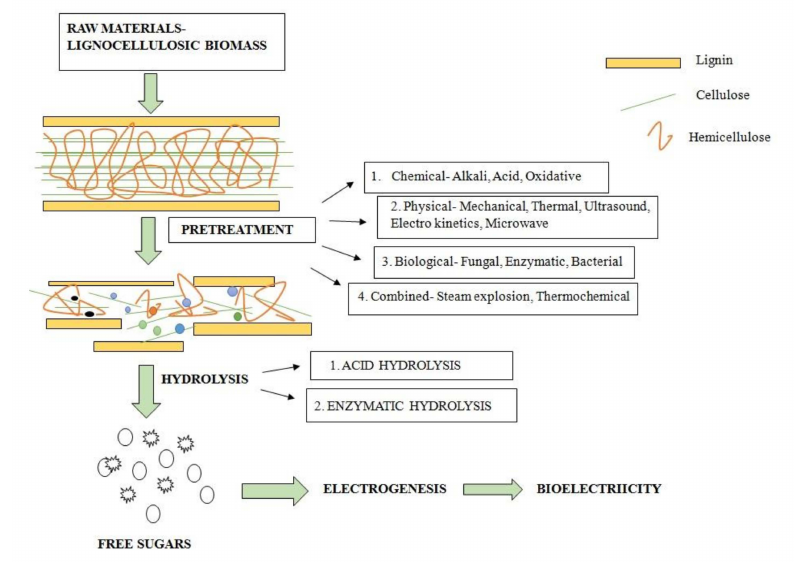
Figure 1. Effect of pretreatment on the biomass